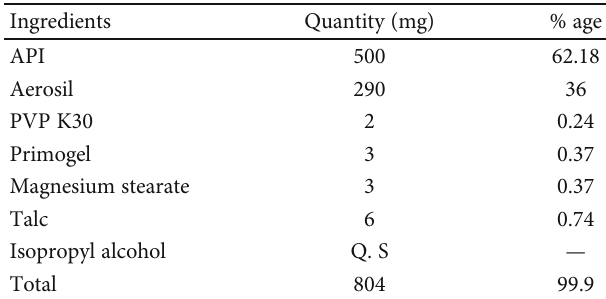
Table 1: Formulation of granules.